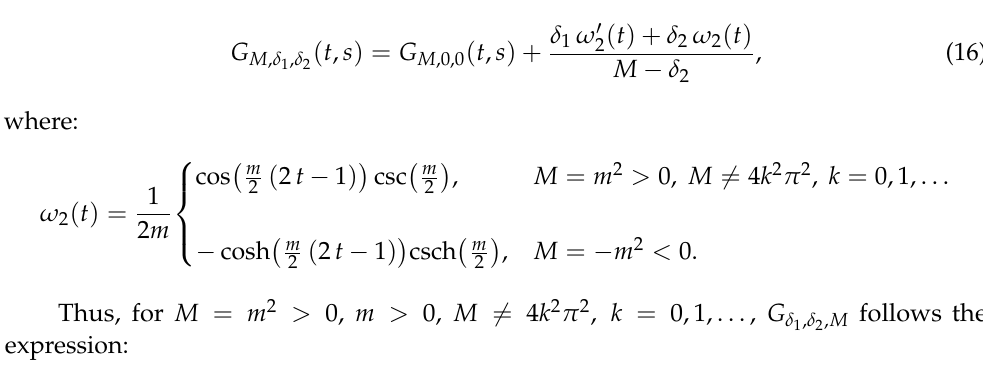
Figure 1. The blue region represents the positive sign of G M ,0, δ the negative sign of G M ,0, δ